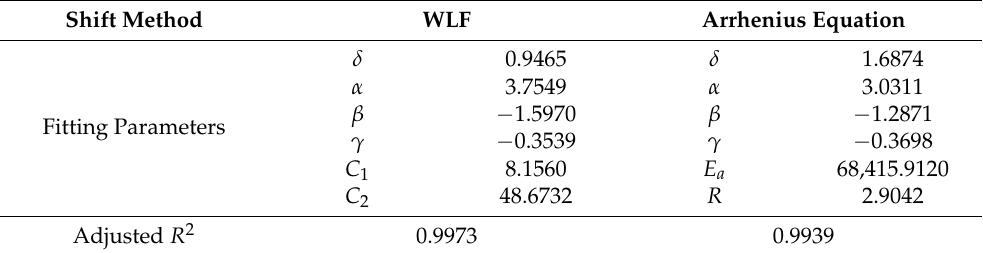
Table 4. Fitted parameters and adjust R 2 of master curves.